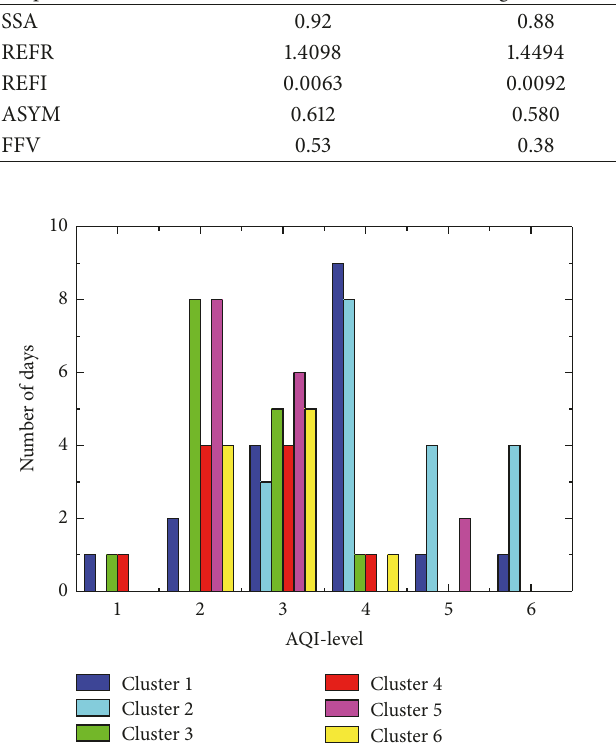
Figure 5: Numbers of each cluster observed in per-AQI level from 2013 to 2014 at Beijing